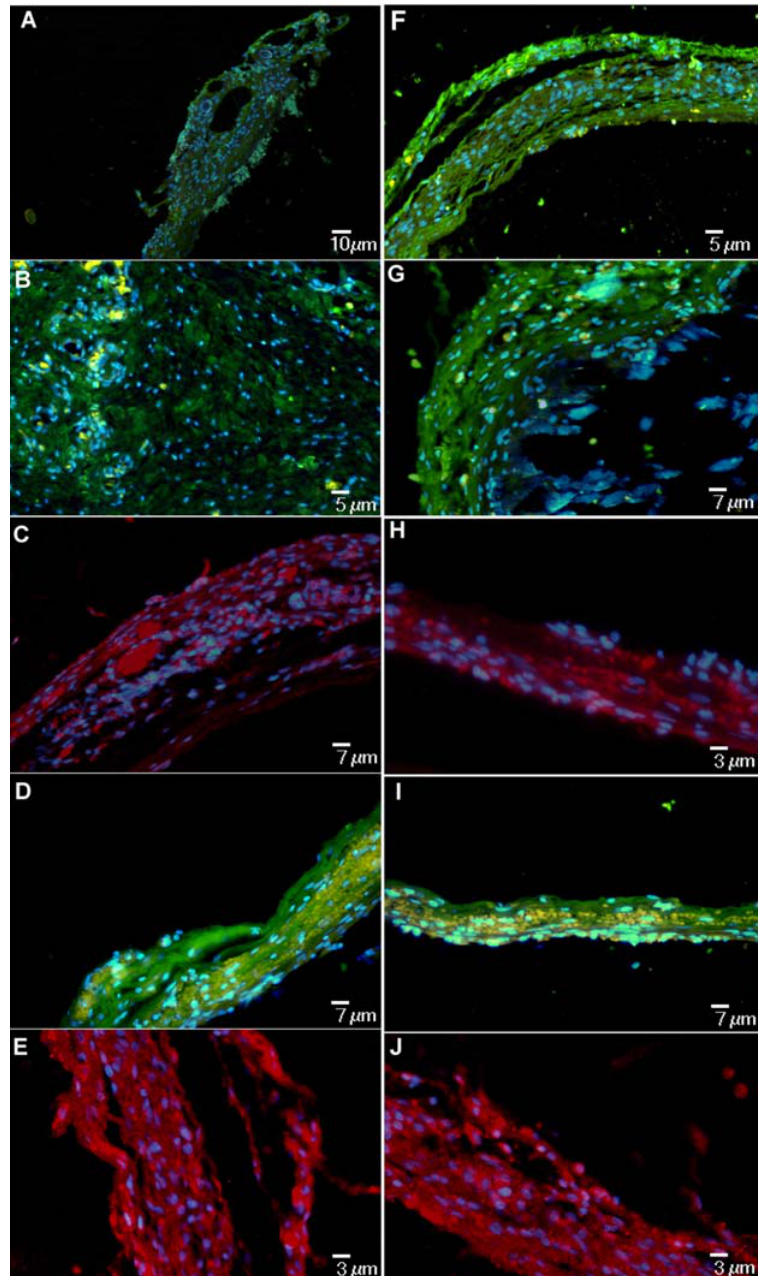
Figure 7. Immunofluorescence confirming the presence of a mineralized extra cellular matrix on concave texturing. The panel shows positivity for Collagen I ( A ) FITC (green) (Calibration Bar=10 m m), BAP [Bone Alkaline Phosphatase] ( B ) FITC (green) (Calibration Bar=5 m m), OC [Osteocalcin] ( C ) PE (red) (Calibration Bar=7 m m), ON [Osteonectin] ( D ) FITC(green) (Calibration Bar=7 m m) and BSP [Bone Sialoprotein] ( E ) PE (red) (Calibration Bar=3 m m). The same analysis confirming the presence of a mineralized extra cellular matrix on smooth texturing. The panel shows positivity for Collagen I ( F ) FITC (green) (Calibration Bar=5 m m), BAP ( G ) FITC (green) (Calibration Bar=7 m m), OC ( H ) PE (red) (Calibration Bar=3 m m), ON ( I ) FITC (green) (Calibration Bar=7 m m) and BSP ( J ) PE (red) (Calibration Bar=3 m m). Nuclear staining is obtained with DAPI